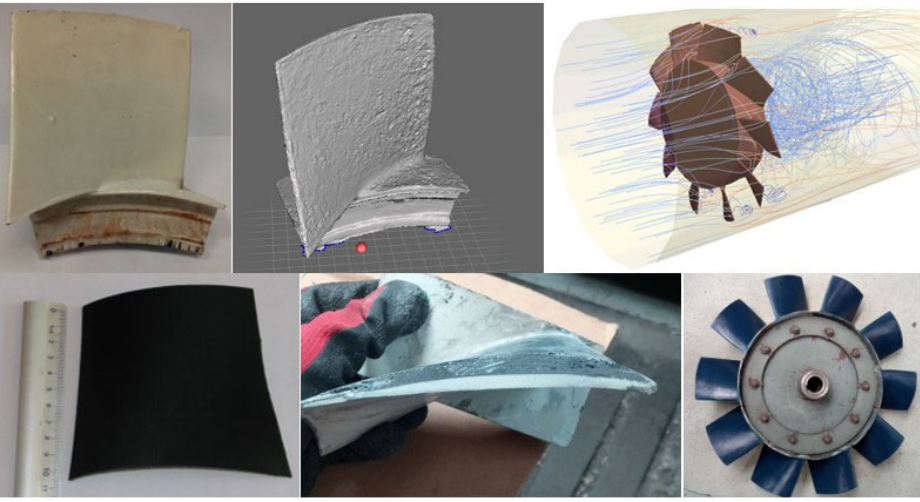
Figure 1. Stages of rotor prototype preparation using state-of-the-art prototyping methods.